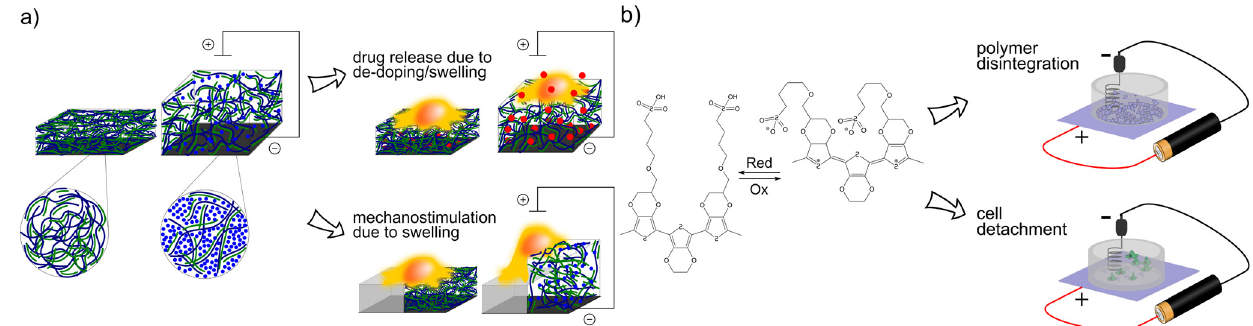
Figure 4. Organic bioelectronics using electrochmical swelling and de-doping properties of conductive polymers. ( a ) Swelling behavior in conducting polymers depends on the incroporation of solvent molecules into the polymer. Diffusion of solvent into the polymer is triggered by electrochemical switching and the creation of excess charges in the polymer matrix. Electrochemical reduction of p-doped conducting polymers leads to dissociation of the polymer and doping ion. The de-doping/swelling properties of conducting polymers can be used in organic bioelectronic devices for electronically triggered drug release and facilitates mechanostimulation of cells; ( b ) Self-doped conducting polymers have been developed that undergo immense structural changes upon electrochemical switching. The self-doped conducting polymers PEDOT-S:H has been developed to disintegrate upon oxidation when immersed into an electrolyte. Using the same polymer, electronically triggered release of cells from their substrate has been